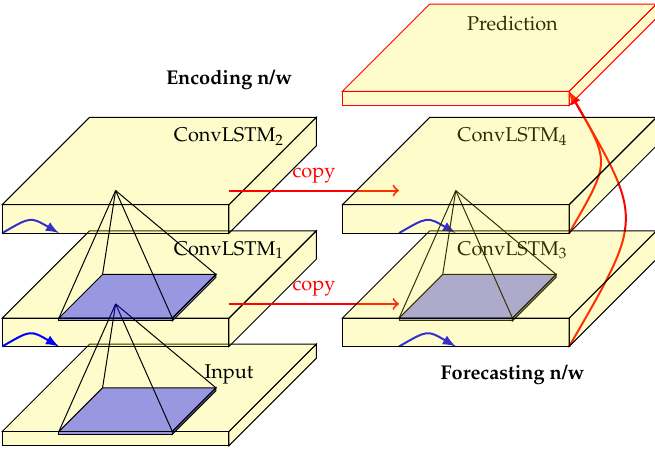
Figure 6. A convolutional LSTM architecture for spatio-temporal